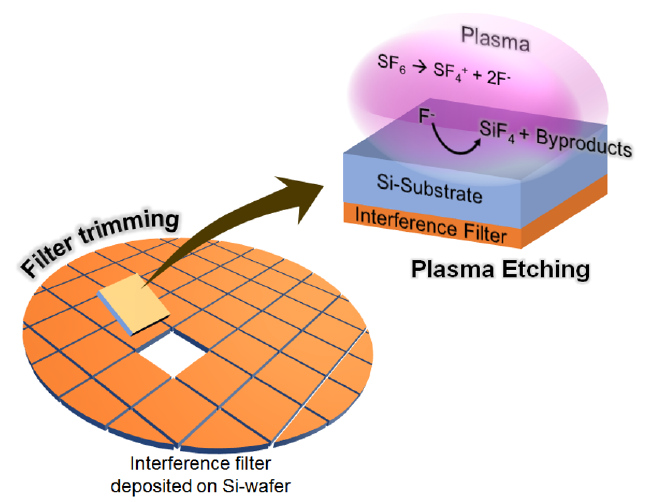
Figure 1. Schematic of the thin and scalable hybrid filter fabrication using the plasma etching technique.